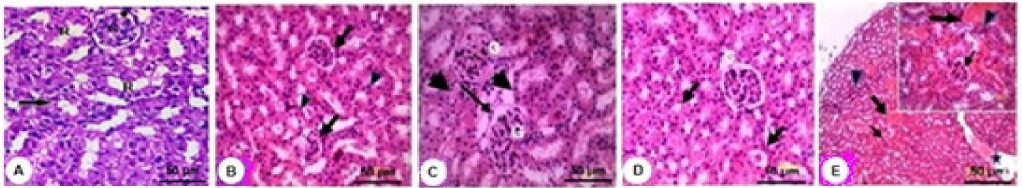
Figure 5. Photomicrographs of kidney sections of rats stained with hematoxylin and eosin (H&E) (200 × , 400 × ). ( A ) Control group showing the renal cortex with the glomeruli (G) that was surrounded by Bowman’s capsule of simple squamous epithelial cells (thin arrow). The renal convoluted tubules are lined with simple cuboidal and simple squamous epithelial cells (thick arrows). ( B ) MLE-treated group showing normal tissue architecture with glomeruli (G) and renal tubules (arrows). ( C ) Cd- treated group showing shrinkage of the glomeruli (G). Renal tubular necrosis, highly eosinophilic epithelial cells (thick arrow), cytoplasmic vacuolated cells that lined the renal tubules (thin arrows), and cellular infiltration in the intertubular sites (circles). ( D ) Cd/MLE group showing slight shrinkage of glomeruli (arrows), well-developed simple cuboidal cells that lined the renal tubules (arrowheads), and no cellular infiltration in the tissue. ( E ) Cd/EDTA group showing severe congestion of the blood capillaries (thick arrows), bleeding in the main blood vessels (star), the malformed glomeruli (thin arrows), and the renal tubules lined with altered eosinophilic and hyperplasia of epithelial cells